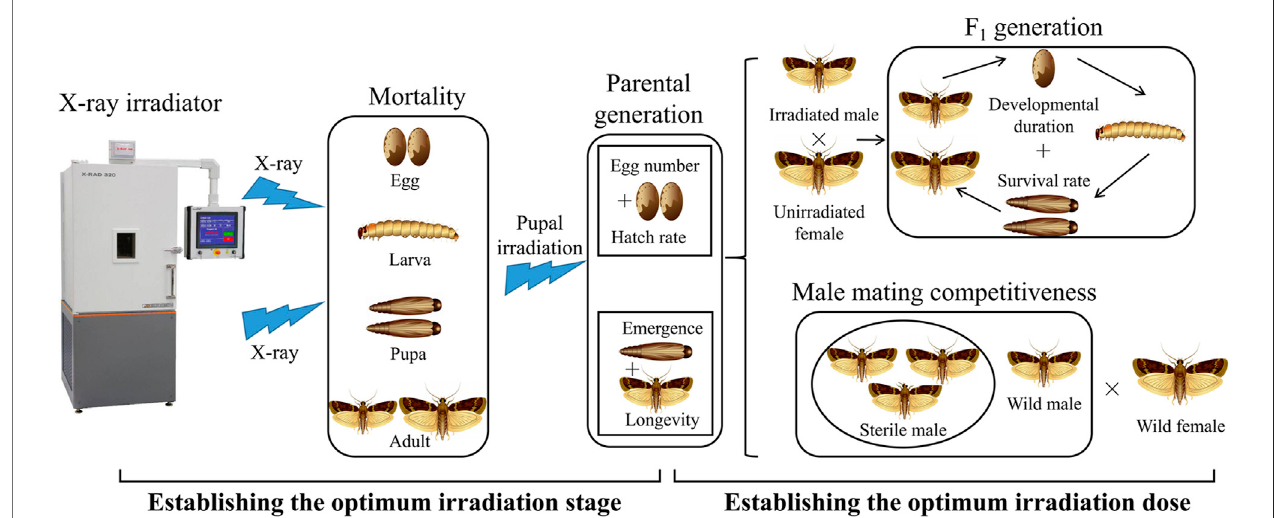
FIGURE 1 | Flowchart showing the methodology used for this